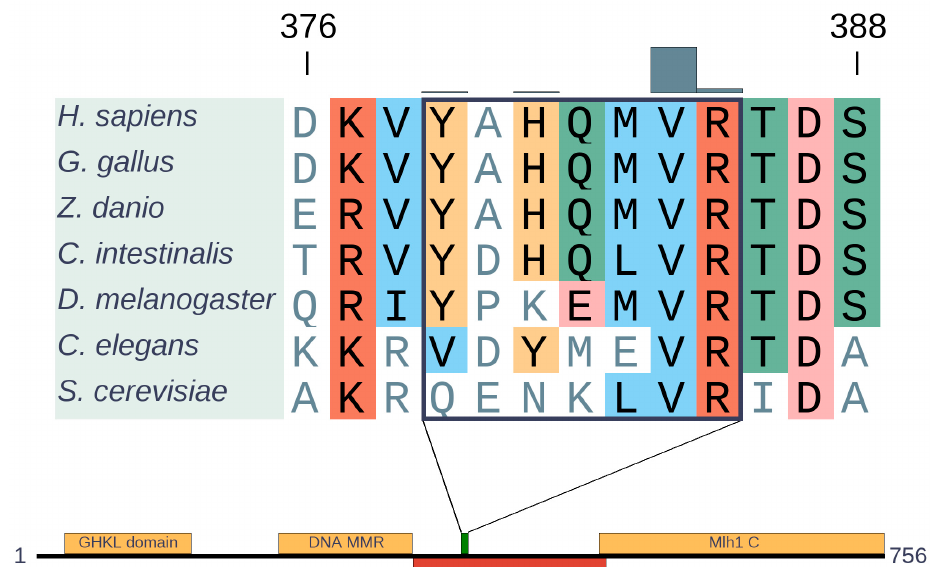
Figure 5. Alignment of MLH1 orthologs generated with MAFFT [15] and domain structure of human MLH1. The segment of the alignment represents the cancer region (highlighted by a rectangle) with the missense mutation distribution depicted by gray bars. Domains are depicted by yellow, disordered regions by red boxes, while the green box indicates the cancer risk region.